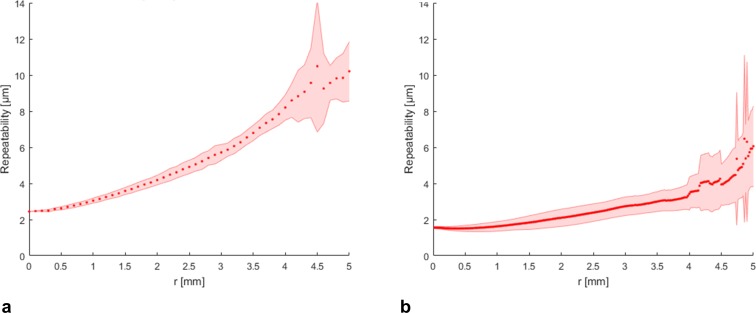
Repeatability of pachymetry.(a) Repeatability of pachymetry data maps obtained with Pentacam AXL (left) and (b) CASIA 2 (right) averaged alongconcentric rings ± standard deviation (shaded area) as a function of the radial distance r from the corneal apex.